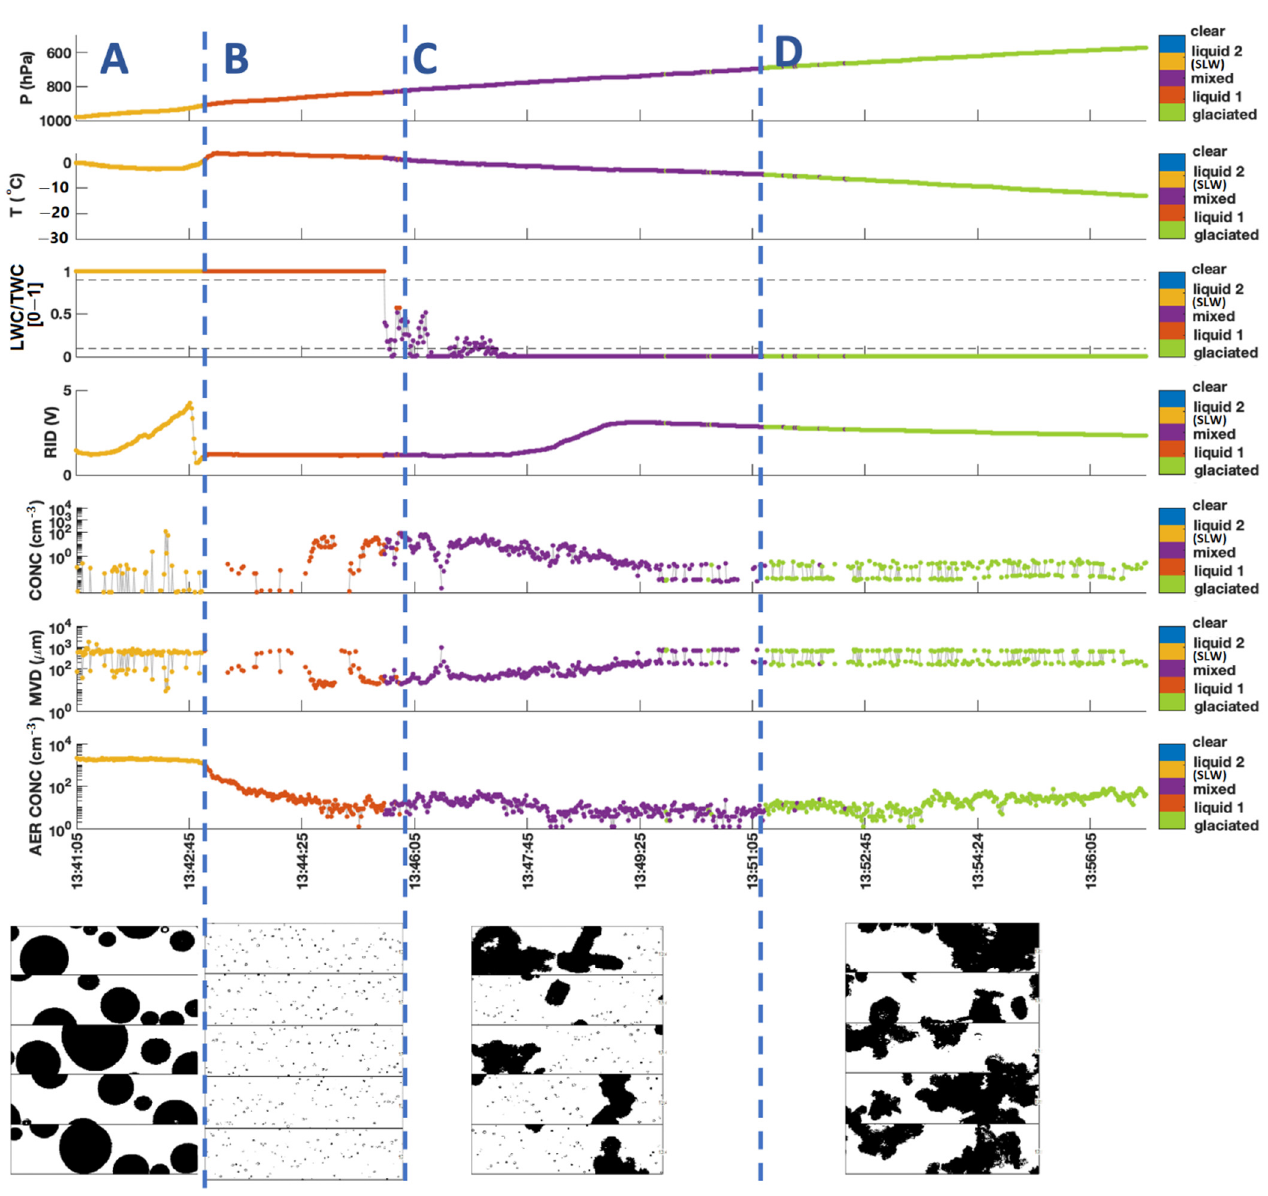
Figure 9. ( Top ): Same as Figure 8, but for the selected time interval between 13:41 and 13:57 UTC on 23 February 2019 (F20). ( Bottom ): 2D-S validation images for four different cloud phases. 2D-S Image resolution is 10 µm and frame height represents ~1.3 mm.